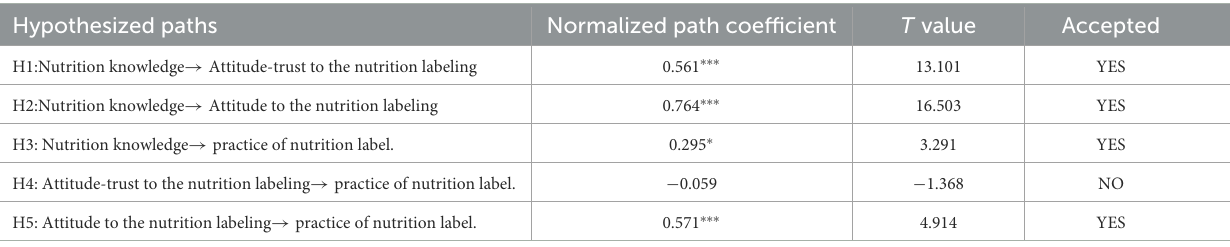
TABLE 8 Test results of the hypothesis. Hypothesized